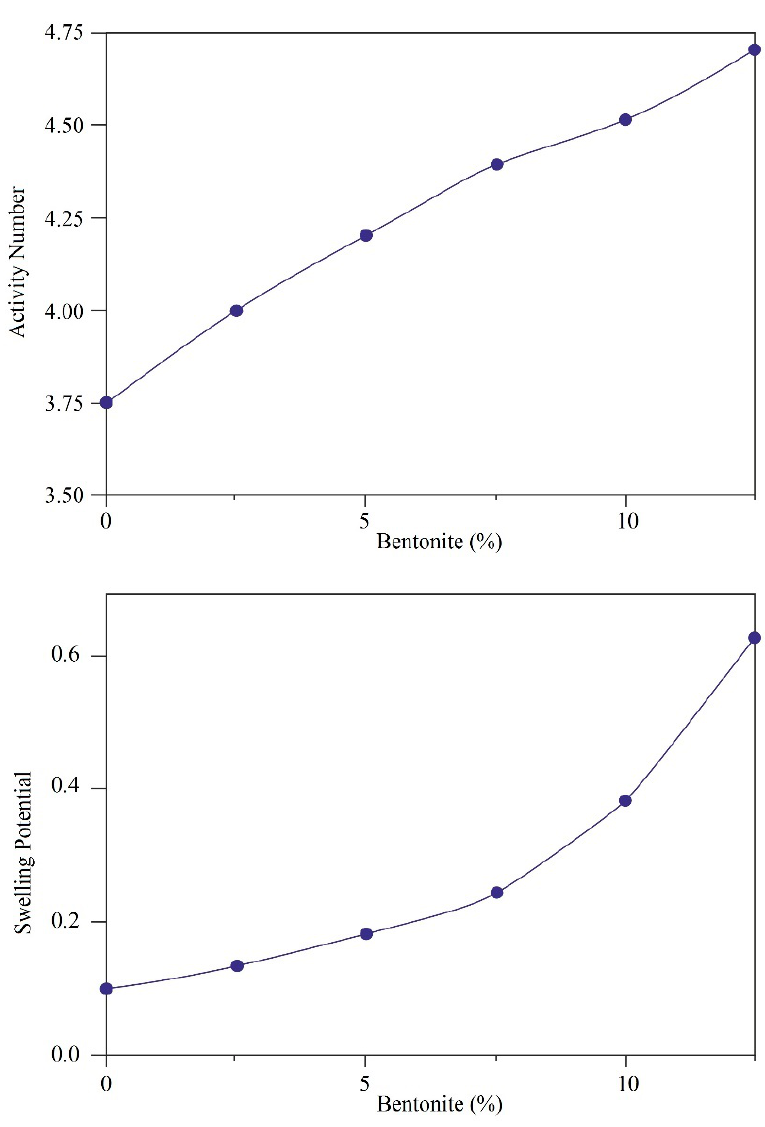
Figure 4. Effect of the Bentonite additive on swelling and activity variation in clayey soil.